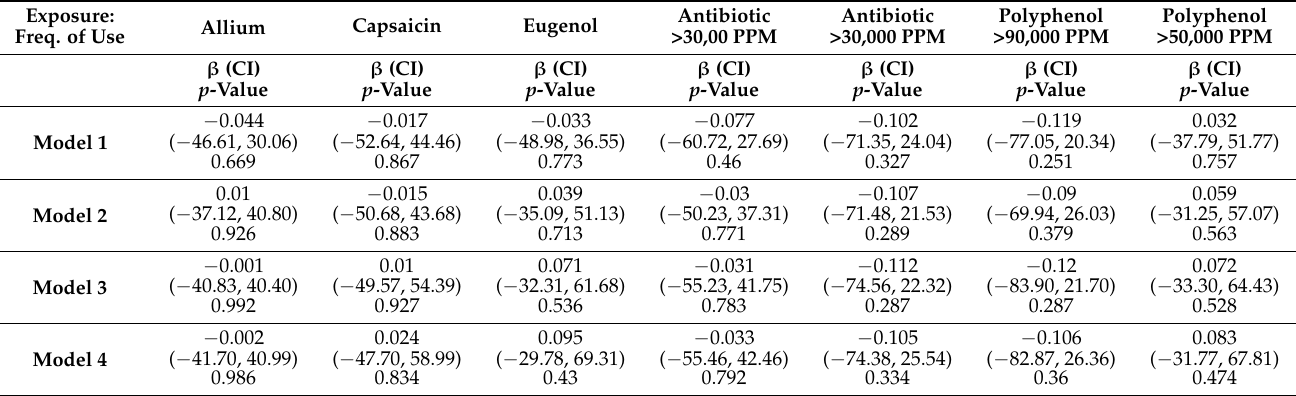
Table 5. Association between frequency of culinary herb use and Actinobacteria